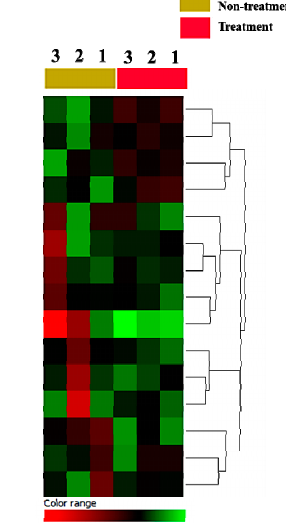
Figure 2. E. coli secretome metabolite identification. A heatmap and hierarchical cluster analysis showed only 15 excreted E. coli metabolites in the culture media of MDA-MB-231 cells compared to the controls’ conditioned media.